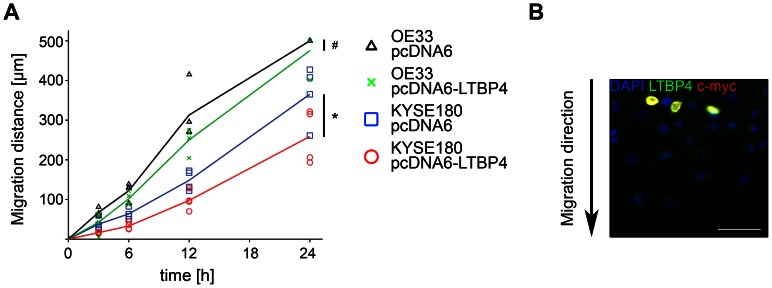
Re-expression of LTBP4 leads to less migration ability of esophageal carcinoma cells.A) Migration distance of OE33 and in KYSE180 cells after transient transfection with either pcDNA6 as a control or pcDNA6-LTBP4 within 24 h. Experiments were repeated at least 3 times. The symbols represent the results of each individual experiment and the graphs document the respective mean values. Significances are given: #p = n.s. and *p<0.05. B) Representative immunofluorescence staining of the migration assay performed with KYSE180 cells re-expressing LTBP4. LTBP4 (green) and c-myc (red) positive cells (yellow) defined the borders of the cell free gap. Only non-transfected cells migrated into the cell free gap. Nuclei were counterstained with DAPI (blue). The arrow indicates the migration direction. Bar graph: 50 µm.